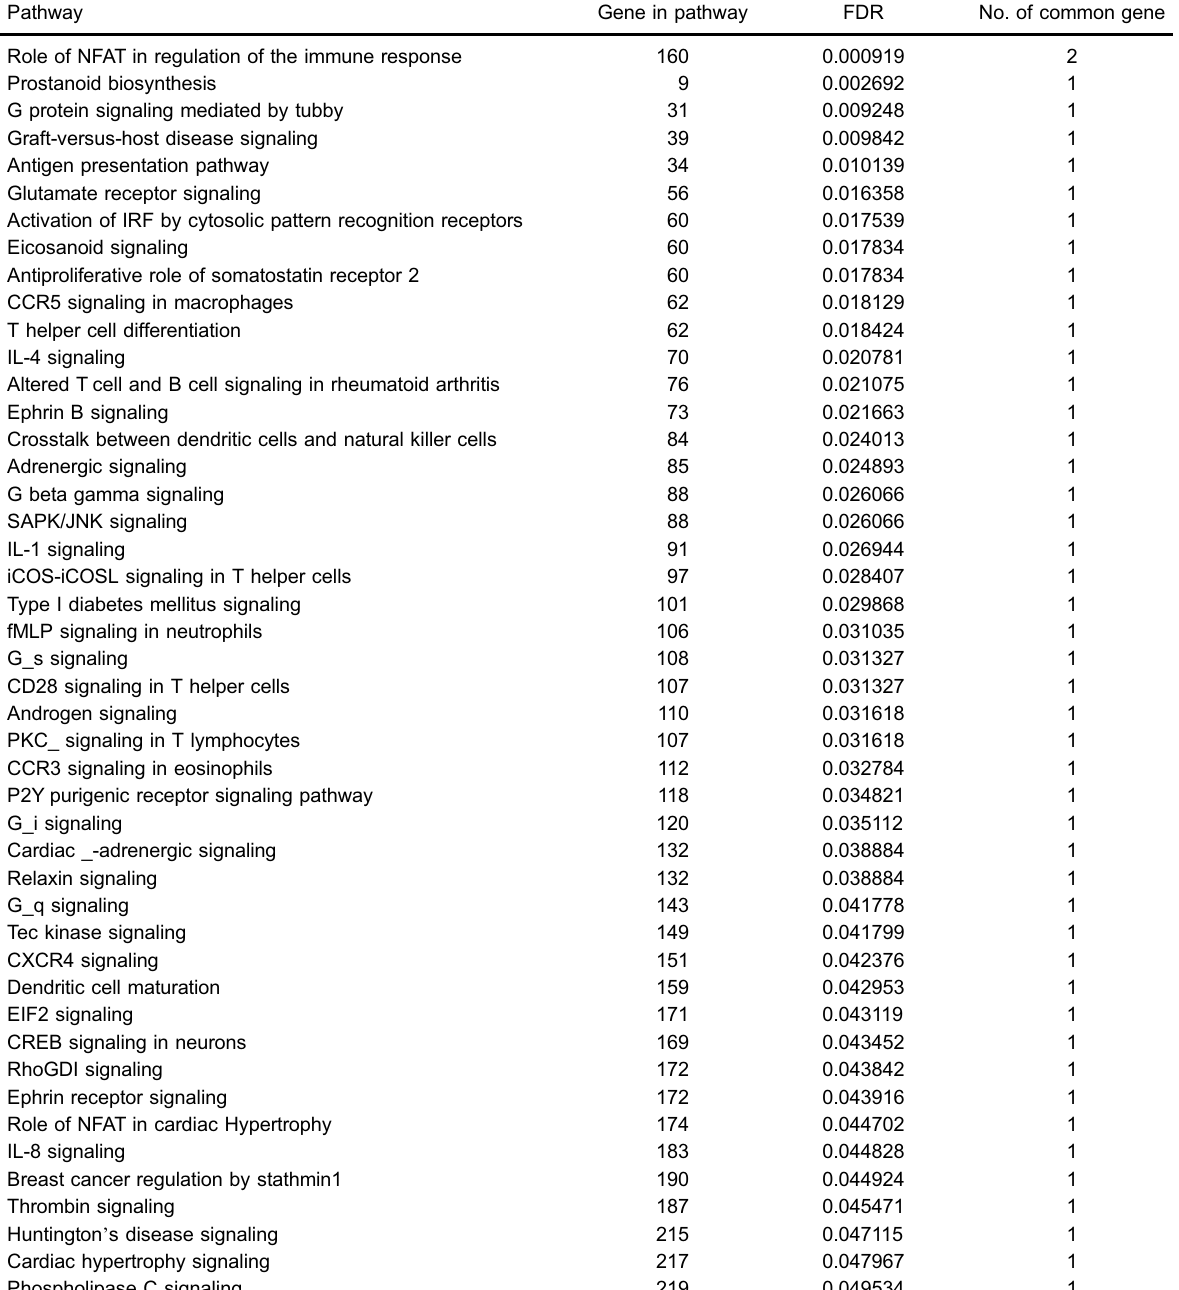
Table 2. Pathways enriched by differentially expressed genes (DEGs).